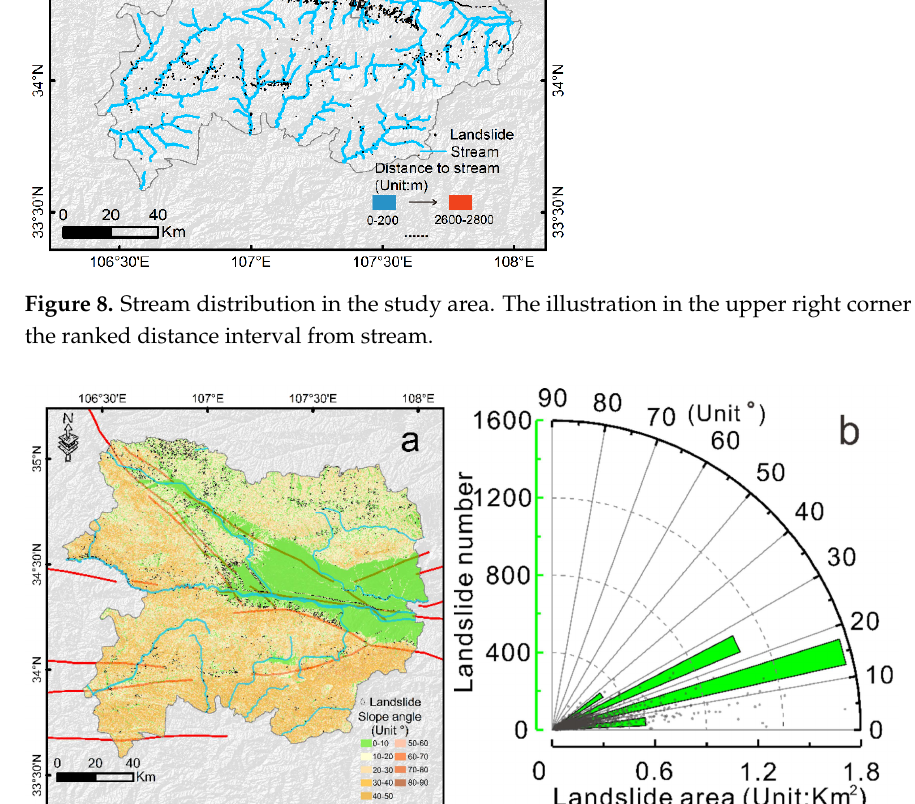
Figure 9. ( a ) Slope distribution in the study area. ( b ) Landslide distribution in respect to slope angle and landslide area.